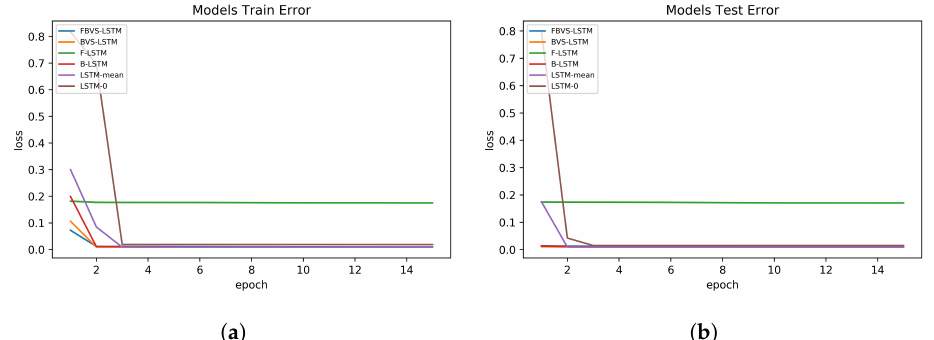
Figure 6. Models performance in Beijing PM2.5 dataset. ( a ) Training set errors; ( b ) Test set errors.